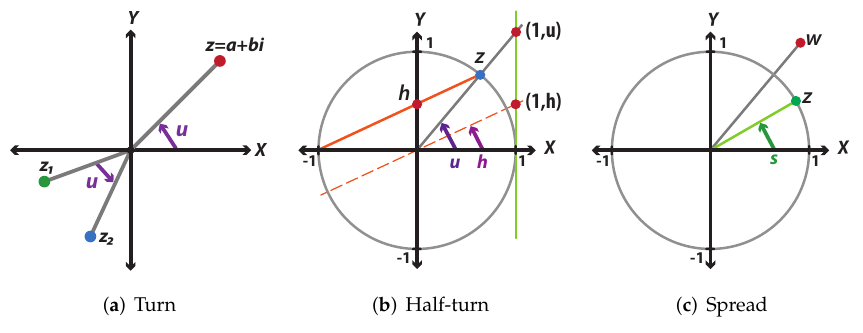
Figure A1. Rational analogs for